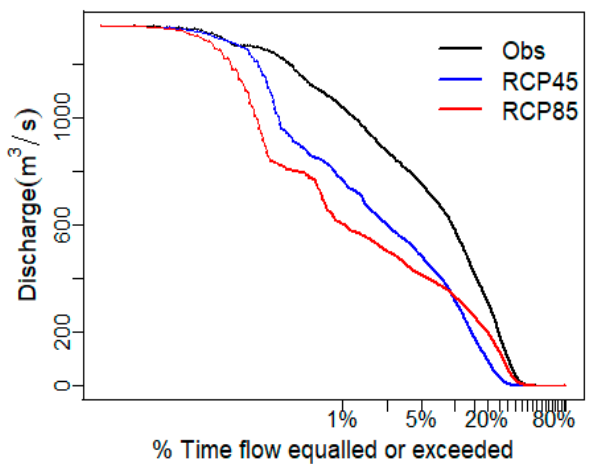
Figure 13. Flow duration curve comparison between observation, RCP 4.5 and RCP 8.5 discharge.